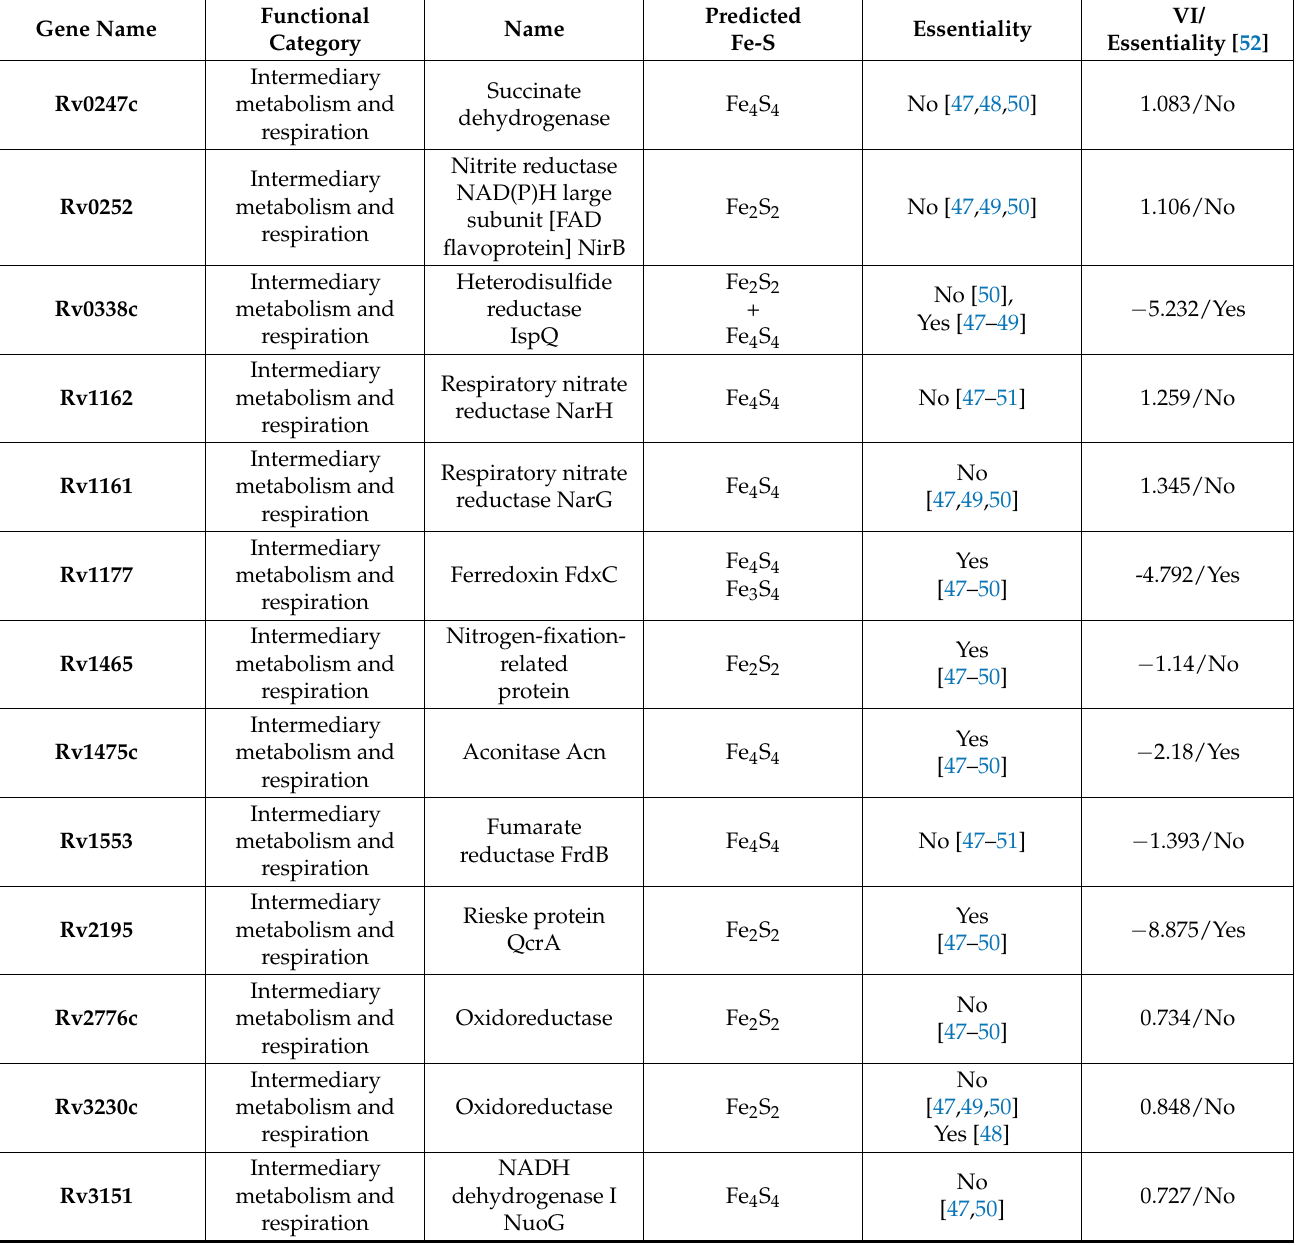
Table 1. Predicted Fe-S proteins in Mtb and their essentiality. Genome-wide gene expression tuning using CRISPR interference system. Vulnerability index (VI) and gene essentiality (yes/no) are given (data extracted from DataS2 in [52]). For comparison, genes encoding the targets of first-line TB therapy ( rpoB , inhA , and embAB ) have a VI value of − 9.5, − 9.9, − 5.85 and − 6.45, respectively [52]. Gene for in vitro growth of H37Rv by analysis of saturated Himar1 transposon libraries [47]. Gene for in vitro growth of H37Rv in a Mtb YM rich and Mtb minimal media by Tn-seq studies [50]. Gene by Himar1 transposon mutagenesis in H37Rv and CDC1551 strains [48,49,51]. Essentiality is defined as a gene essential for growth and/or survival. Even though NuoI (Rv3153) displays a vulnerability index value (VI: − 2.127) in the range of a potential vulnerable gene, the high variability between the lower and higher bounds of the vulnerability index makes this gene likely